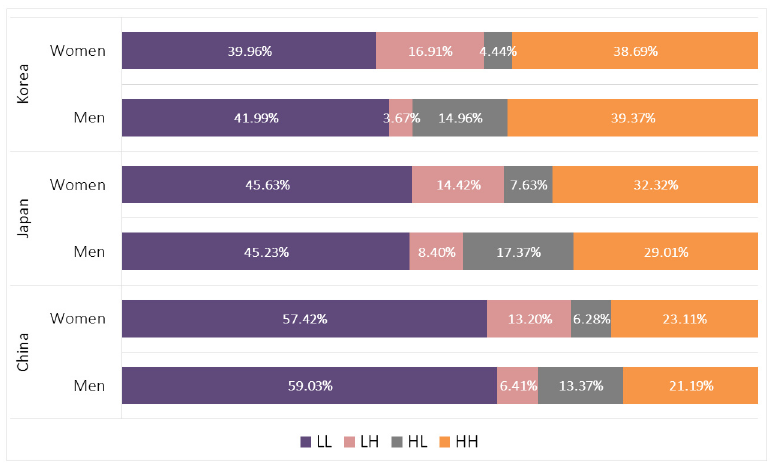
Fig 4. Education Concordances by Gender in China, Japan, and Korea. Percentages in bars indicate corresponding ratios of intra-couple concordance of educational achievement by gender in each country.